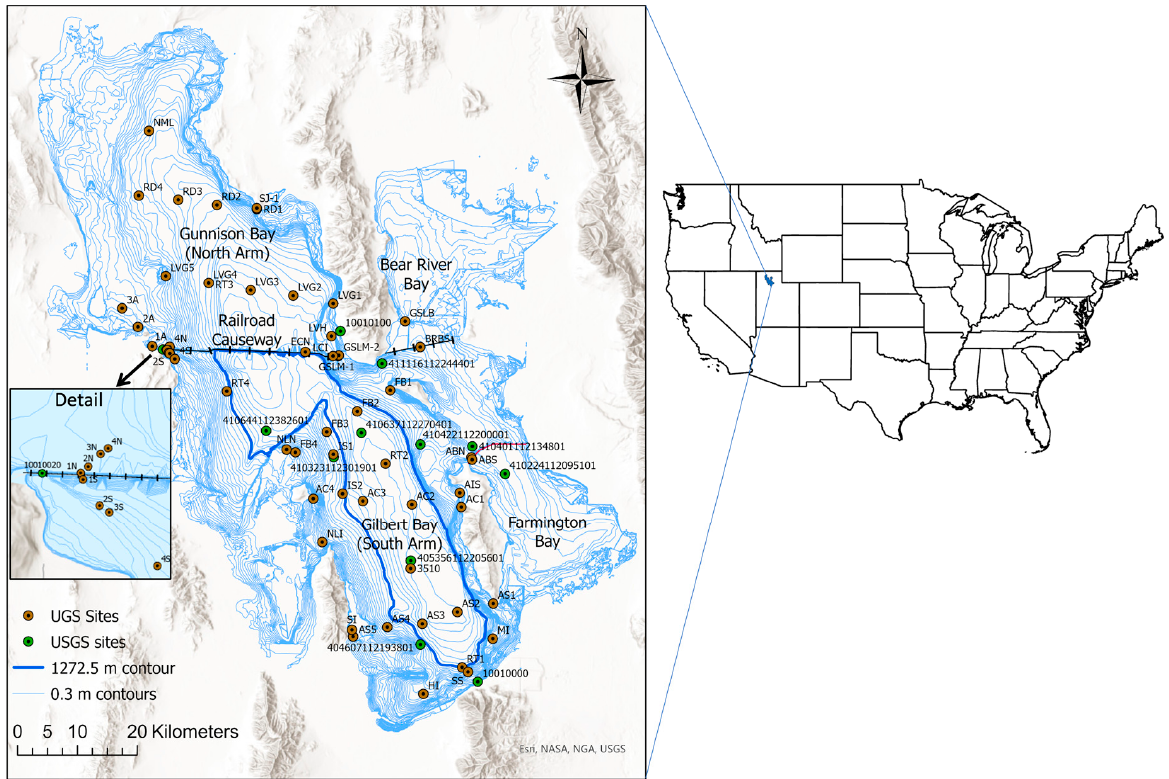
Figure 1. Locations of historical UGS (orange) and USGS (green) sampling sites within the GSL. Light blue lines are 0.3 m contours. Dark blue line is the 1272.5 m contour, within which the DBL can be found. Location of GSL in Northern Utah, USA, is shown.